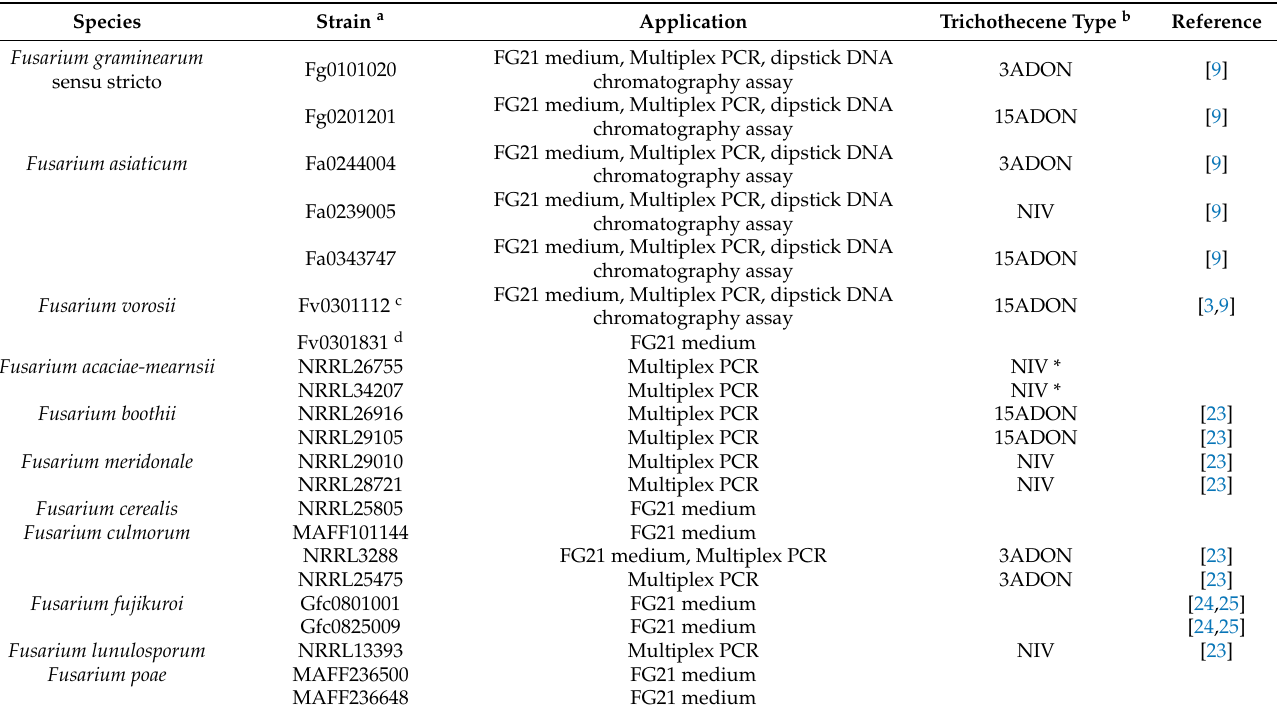
Table 1. Strains used in the current